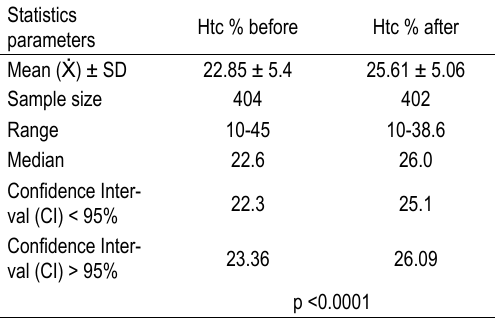
Table 4. changes of Hematocrit before and after transfu- sion treatment in patients with Gastro intestinal Bleeding